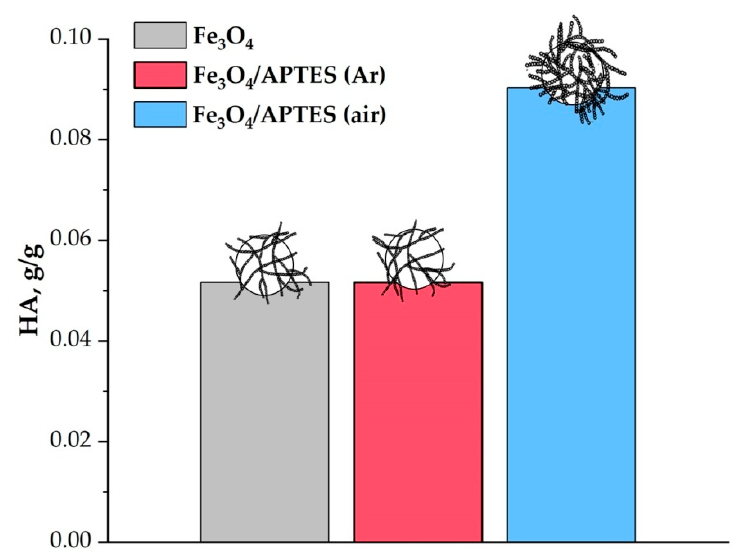
Figure 8. Amount of HA for complete coverage of 1 g NPs given in g. (pH 3, zeta potential~ − 20 mV and pH 9, zeta potential~ − 40 mV, 0.01 M KCl) ( p -value < 0.05 for Fe 3 O 4 or Fe 3 O 4 /APTES (Ar) and Fe 3 O 4 /APTES